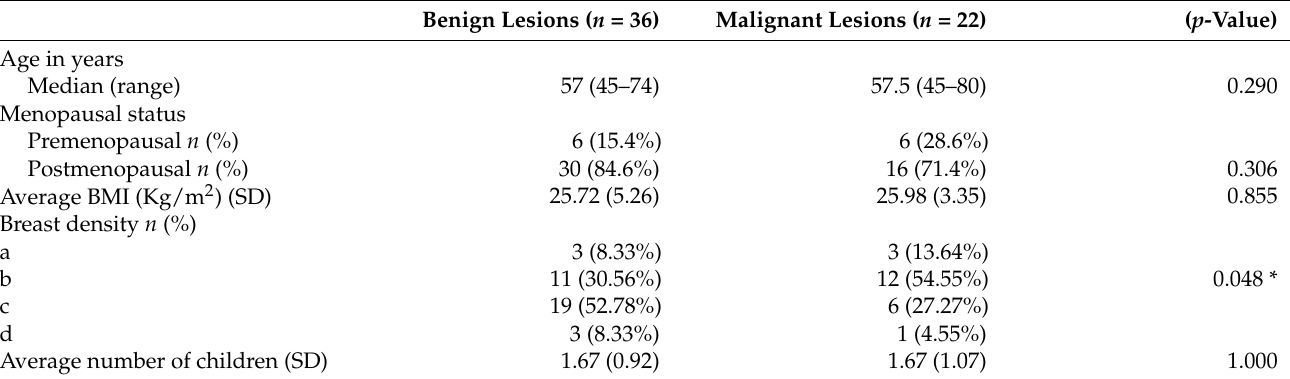
Figure 1. Results of the clinical evaluation as an overview. Breast MRI (magnetic resonance imaging), mammography (MG), n (number). Table 1. Characteristics of women with benign and malignant findings in